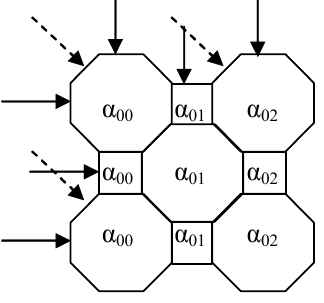
Figure 9. A 3 × 3 array of cells with three